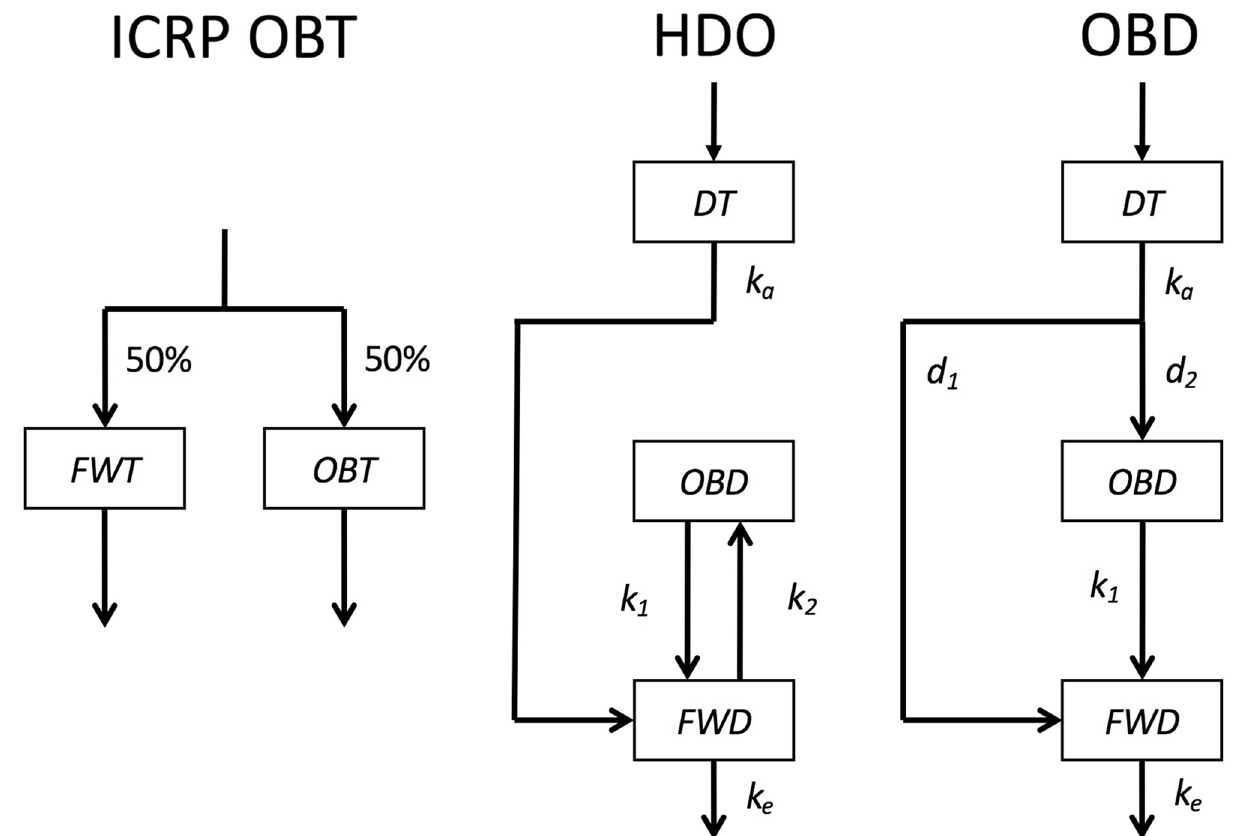
Figure 1. Structure of metabolic model of hydrogen isotopes. ICRP OBT is the model adopted by the International Commission on Radiological Protection (ICRP) to calculate the dose coefficient for ingested OBT 5 . HDO and OBD, the models developed to analyse the amount of D excreted through urine after administration of D-labelled compounds and food. FWT, free water tritium; OBT, organically bound tritium; DT, digestive tract; OBD, organically bound deuterium; FWD, free water deuterium; d m , distribution factor, k m , excretion rate constant (day −1